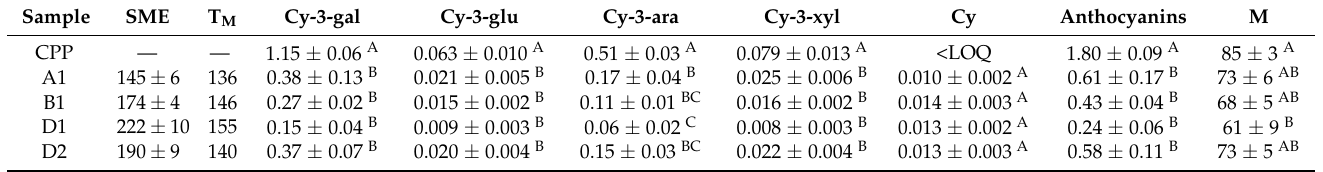
Table 6. Anthocyanins contents of chokeberry pomace powder (CPP) and samples after extrusion processing (g/100 g dm, mean ± SD, n = 2) at water contents of 13% (A1, B1, and D1) and 23% (D2), respectively. SME, specific mechanical energy (Whkg − 1 ); T M , material temperature ( ◦ C); Cy-3-gal, cyanidin-3O-galactoside; Cy-3-glu, cyanidin-3O-glucoside; Cy-3-ara, cyanidin-3O-arabinoside; Cy-3-xyl, cyanidin-3O-xyloside; Cy, cyanidin aglycon; M,